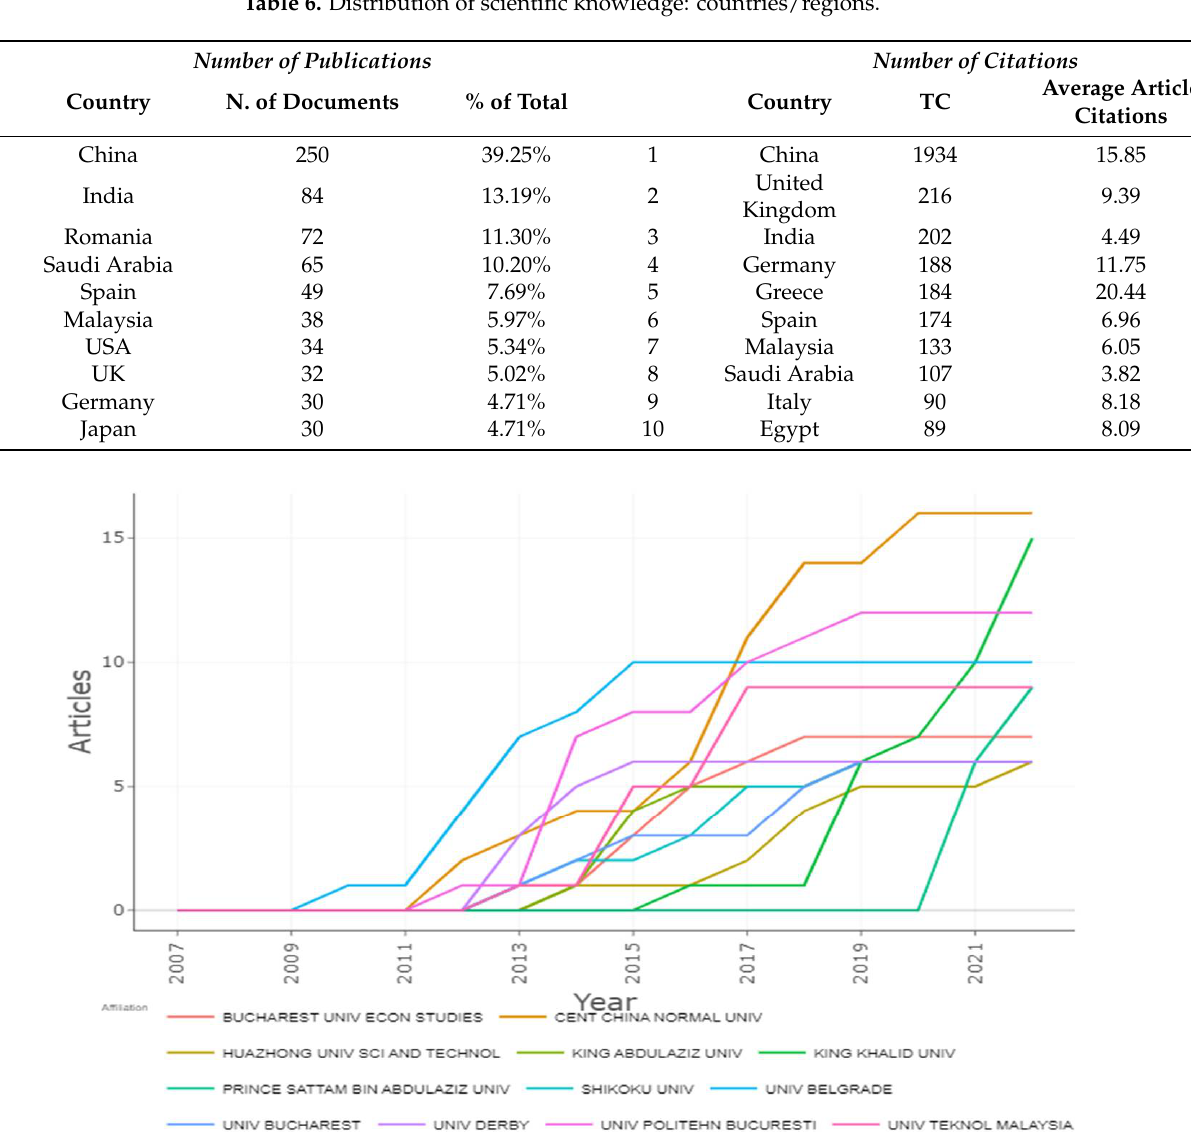
Table 6. Distribution of scientific knowledge: countries/regions.